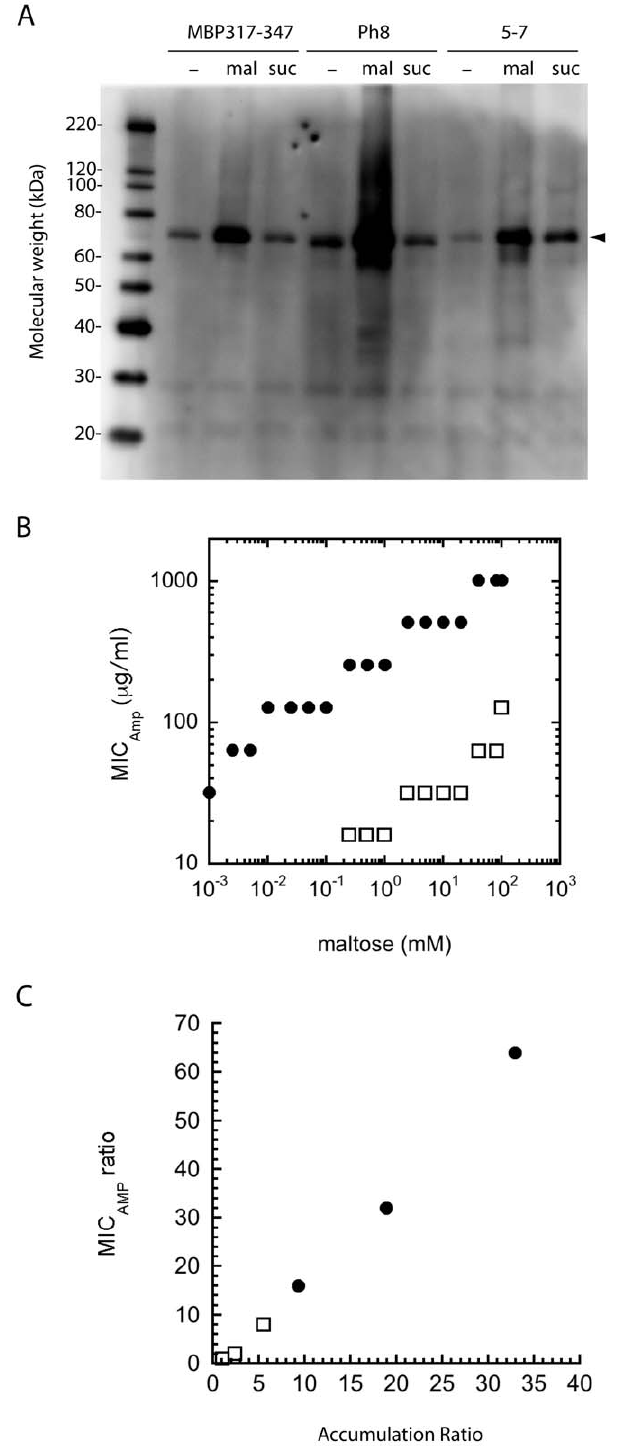
Figure 2. Effect of ligand concentration on MIC Amp and accumulation of phenotypic switches. (A) Western blot using anti- BLA antibodies of the soluble fraction of cells expressing MBP317-347, Ph8 andsucroseswitch 5–7 (arrow, , 70 kDa). Cells were cultured with maltose (mal), sucrose (suc), or neither sugar ( 2 ). (B) Correlation between the MIC Amp and the concentration of maltose added to the culture for cell N ) or MBP317-347(W340A) ( % ). (C) Accu- expressing MBP317-347 ( mulation levels dictate the MIC Amp . Correlation between the accumulation ratio ( + maltose/ 2 maltose), as measured by